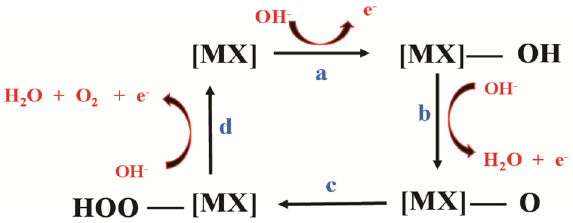
Figure 4. Suggested OER mechanism on metal oxides (MOx) catalyst. Where MX = CdFe 2 O 4 , a-d are reaction steps.